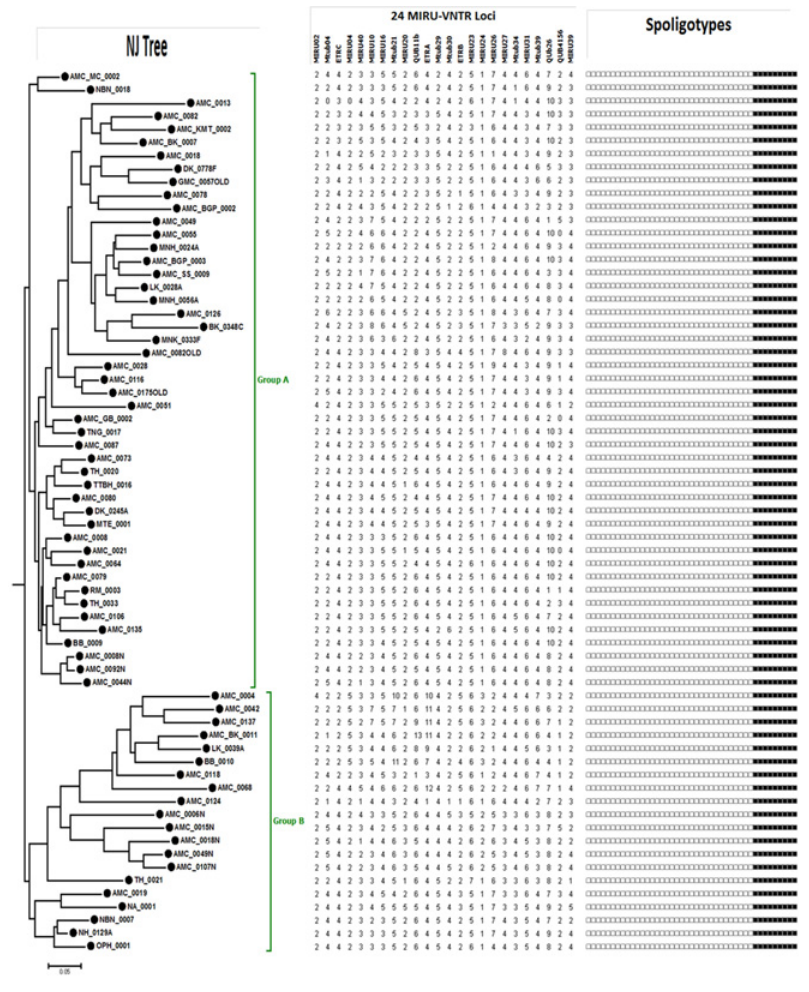
Fig 3. Neighbour-Joining (NJ) tree showing genetic diversity of 67 Beijing isolates from Assam based on 24 MIRU-VNTR loci. Two major clusters (Group A and Group B) and their sub-lineages can be seen from this